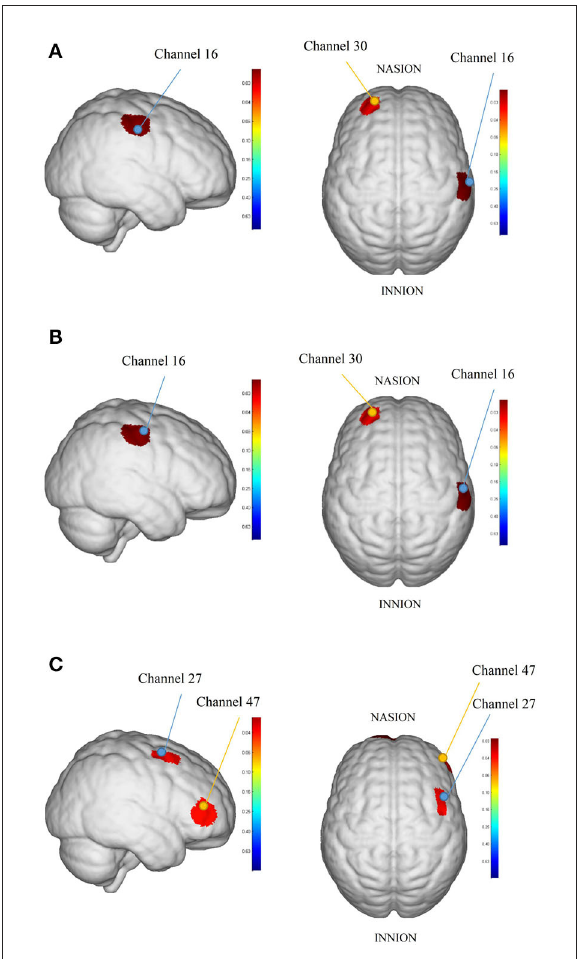
FIGURE4 The cortical maps based on analyzed HbO 2 beta values: (A) was the result between rTMS group and sham rTMS group in block average, (B) was the result between the right-rTMS group and sham right-rTMS group in block average, and (C) was the result between baseline and post-intervention in block differential in the right-rTMS group. The redder color indicates the higher beta value of the channel and the bluer color indicates the lower beta value of the